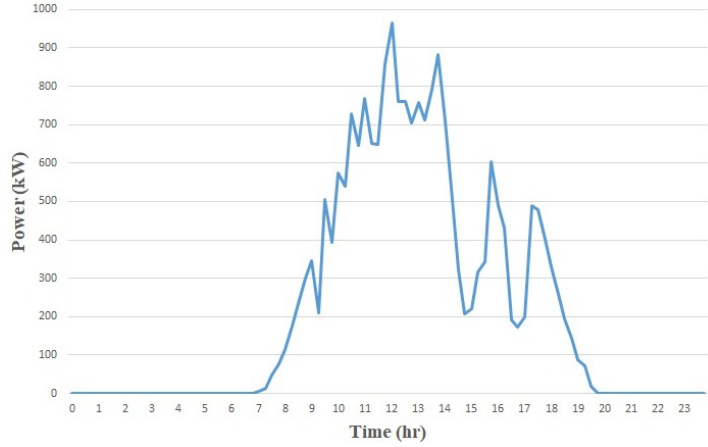
Figure 7. Power ramps at FIU PV site during the 21 August 2017 partial eclipse.